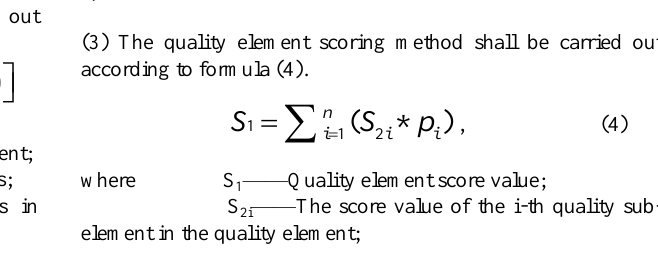
Table 6. Integrate related results inspection content and